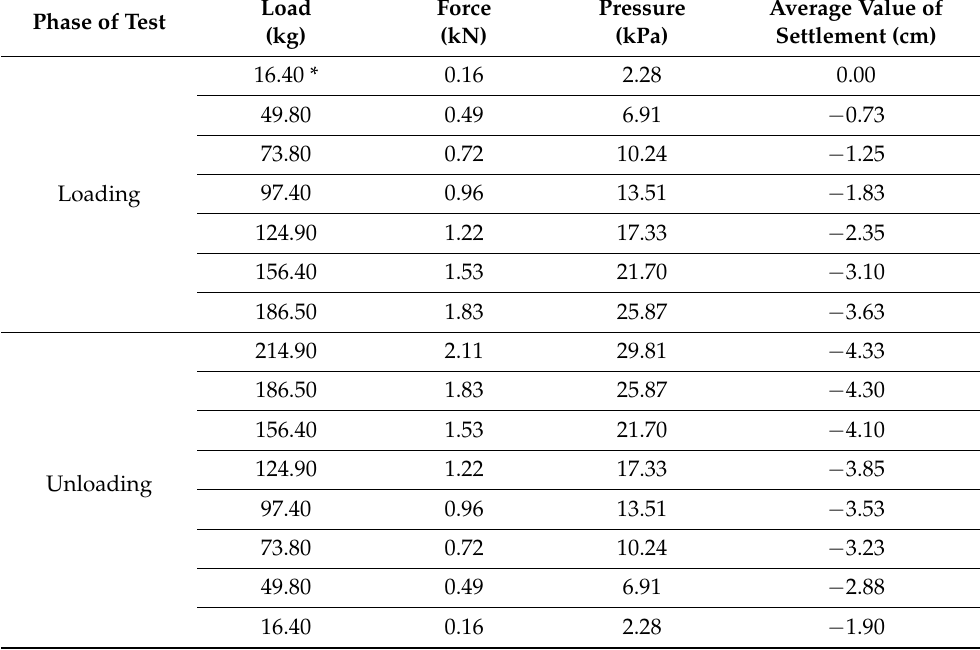
Table 2. Static load test results.